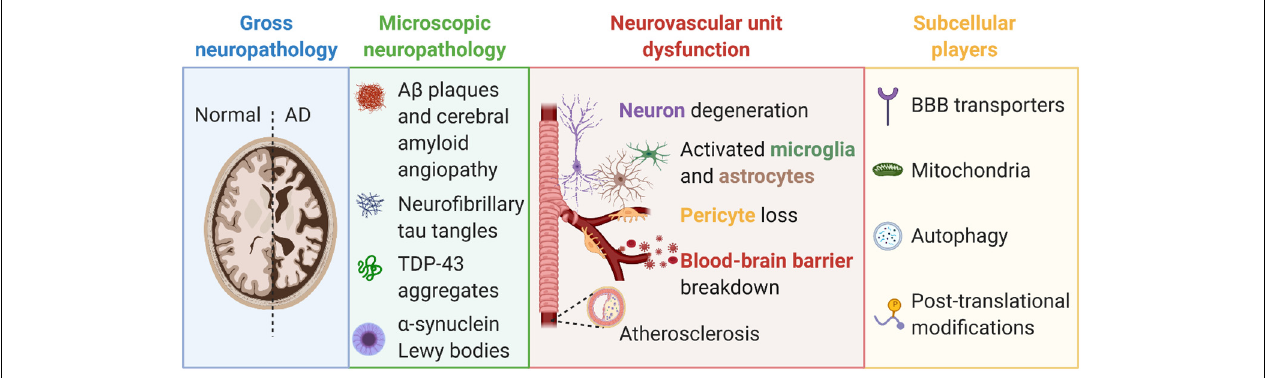
FIGURE 1 | Alzheimer’s disease is characterized by gross pathologies (e.g., brain atrophy and ventricular enlargement, blue box), microscopic neuropathologies (e.g., amyloid- β plaques, tau tangles, and TDP-43 aggregates, green box), neurovascular unit dysfunction (e.g., blood-brain barrier breakdown, pericyte loss, neurodegeneration, and gliosis, pink box), and changes to subcellular players (e.g., blood-brain barrier transporters, mitochondria, autophagy, and post-translational modifications, yellow box). Created with